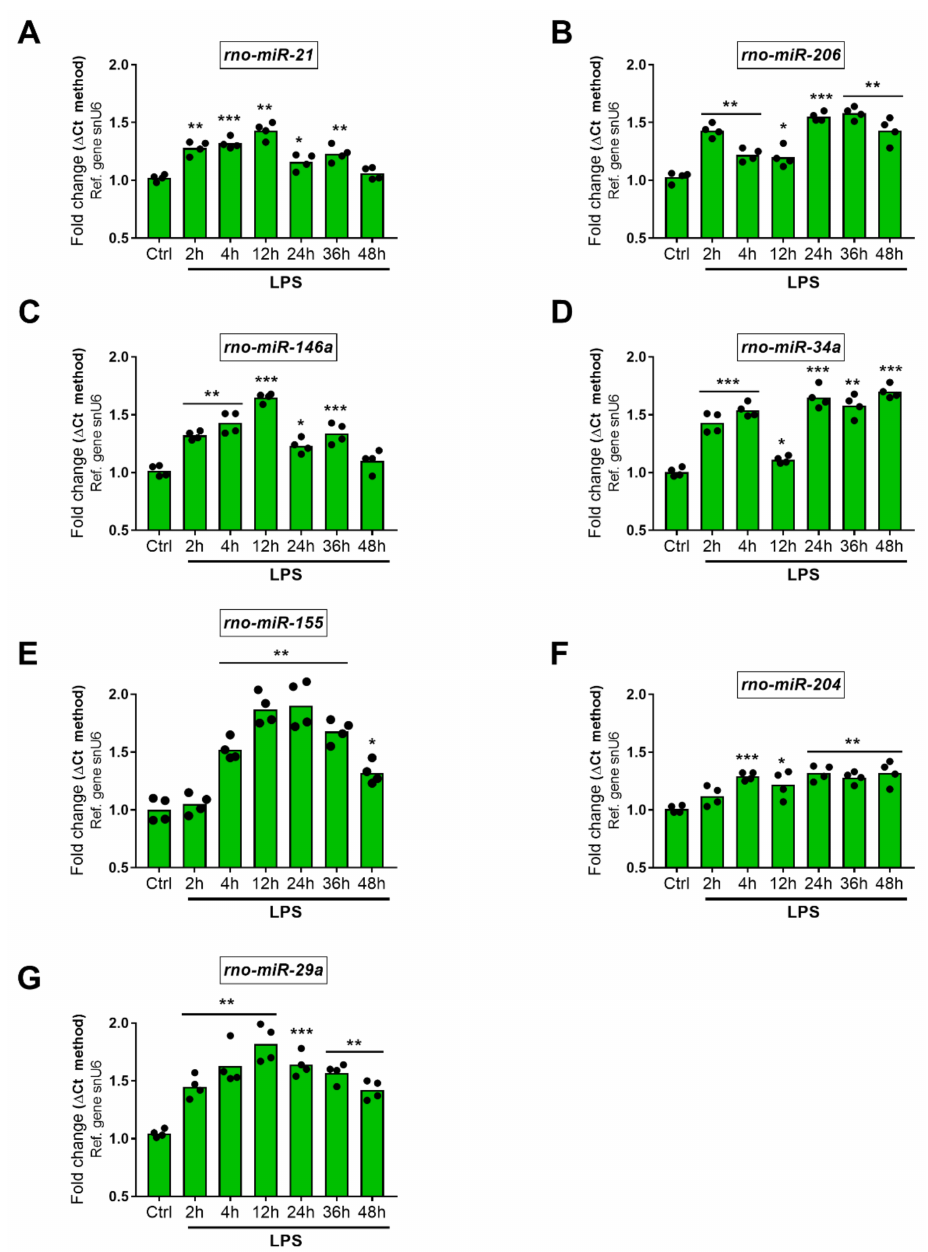
Figure 6. Time-course analyses of upregulated miRNAs following LPS exposure. Each bar graph depicts the expression profile of ( A ) rno-miR-21 ; ( B ) rno-miR-206 ; ( C ) rno-miR-146a ; ( D ) rno-miR-34a ; ( E ) rno-miR-155 ; ( F ) rno-miR-204 and ( G ) rno-miR-29a after treatment with 1 µ g/mL LPS at different time points (0, 2, 4, 12, 24, 36 and 48 h). Ctrl = time 0. Data shown are the mean fold change ± SEM, obtained from two independent experiments, each performed using separate biological replicates ( n = 4). * p < 0.05, ** p < 0.01 or *** p < 0.001 vs. Ctrl; repeated measures ANOVA followed by Fisher’s LSD